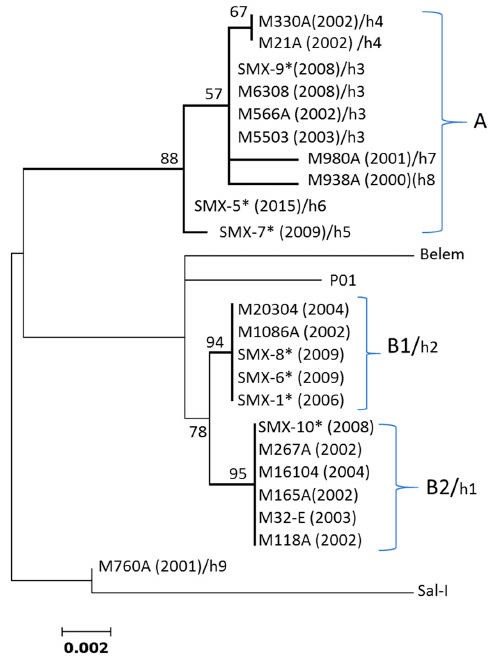
Figure 1. ML phylogenetic tree of the P. vivax cyrpa coding gene for 22 Southern Mexican parasites. Bootstraps above 50% are indicated. Sal I (XM_001615090.1), Belem, and PvP01 (PlasmoDB) were included as reference strains. These M760A isolate sequences did not cluster with other Southern Mexican parasites. The haplotype numbers h1–h9 assigned to each parasite isolate (as in Table 1) are indicated. * indicate sequences obtained in this study. (Year of sample collection).